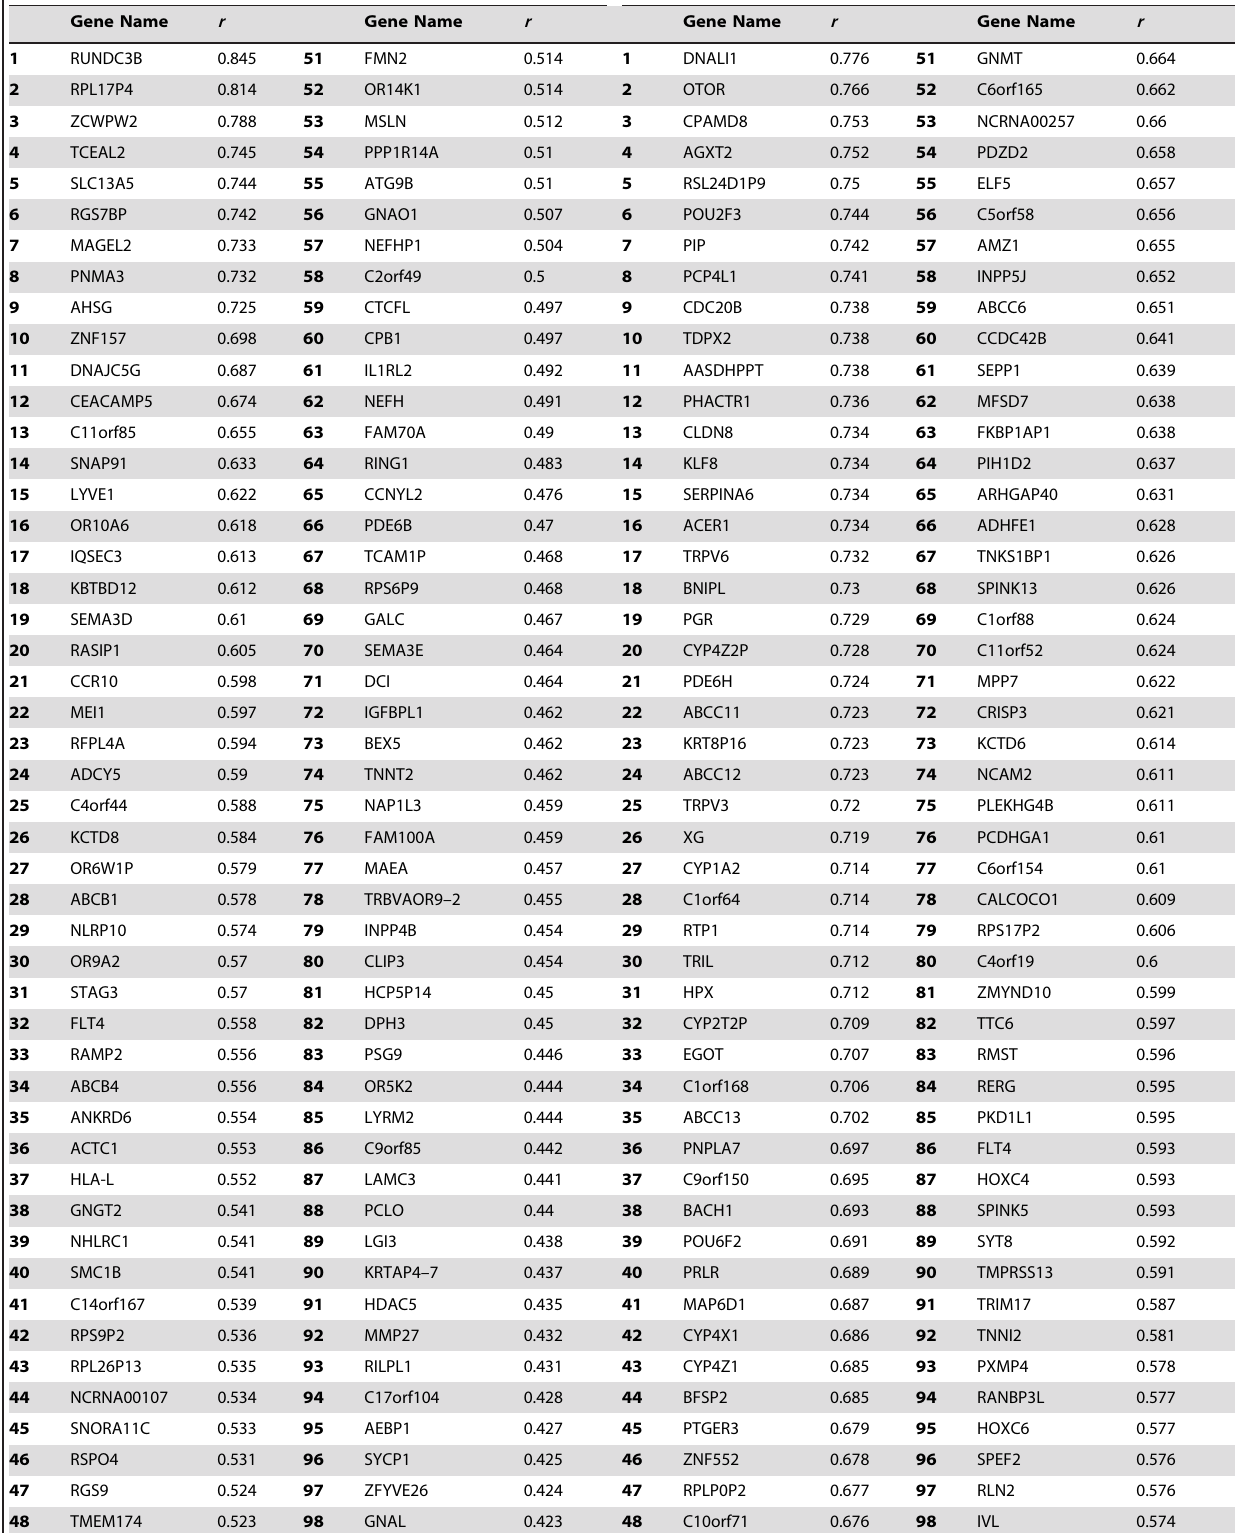
Table 2. The top 100 genes that correlate with viral